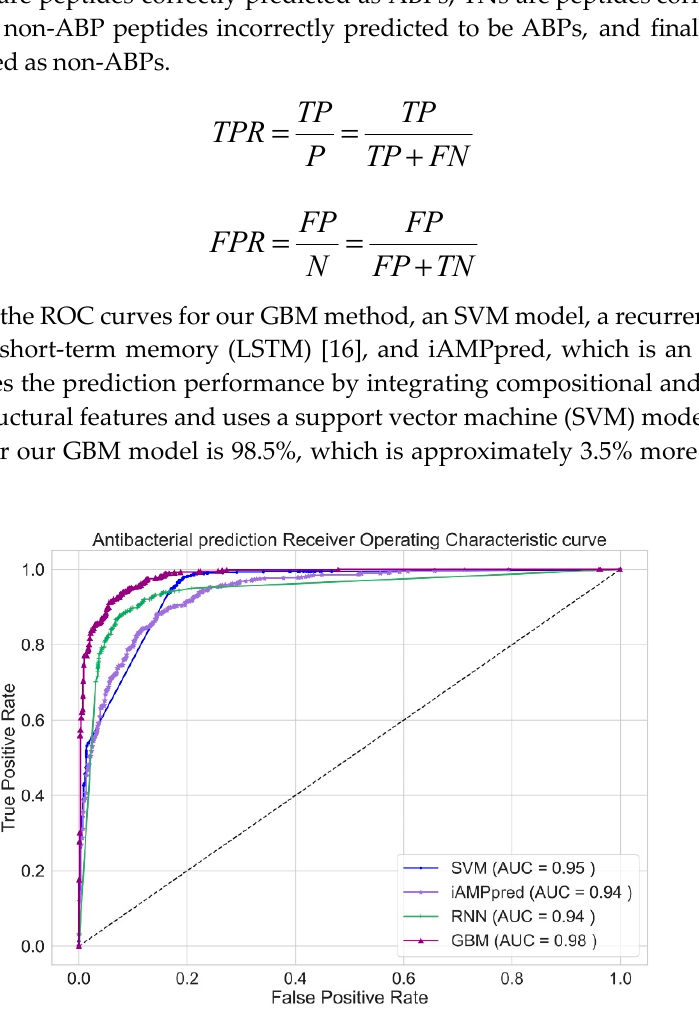
Figure 3. Receiver operating characteristic ( ROC) curves for our gradient boosting model (GBM) approach and three other approaches. Areas under the curve (AUCs) are shown for each model in the